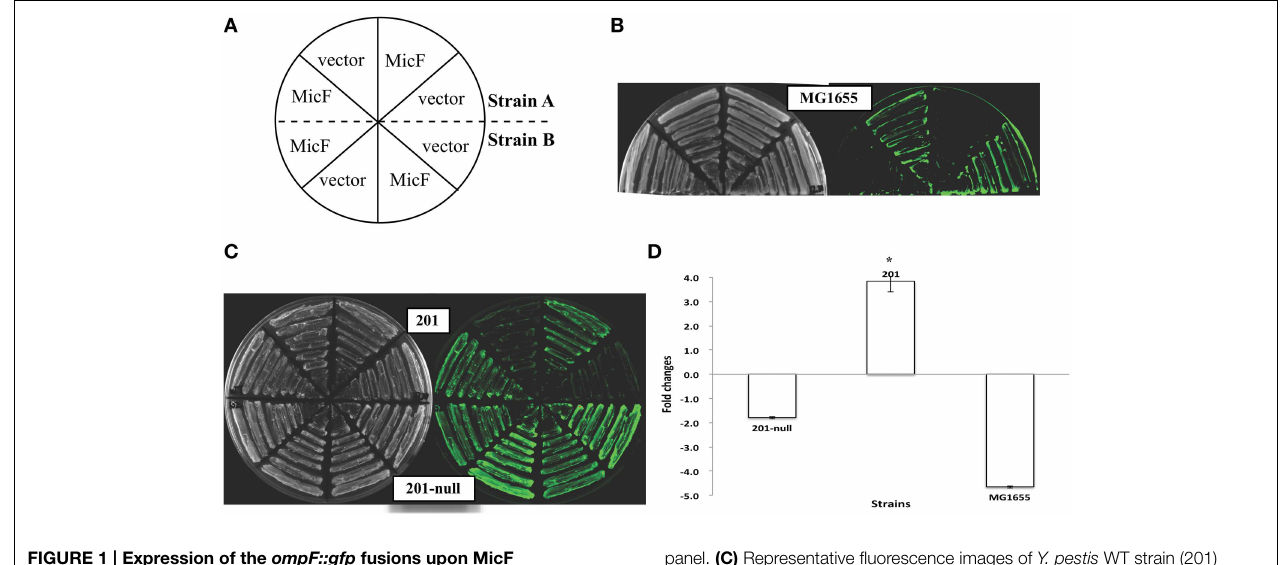
panel. (C) Representative fluorescence images of Y. pestis WT strain (201) and its plasmid-cured derivative strain (201-null). (D) Quantitative measurements of fluorescence produced by the tested strains. Fold changes are provided as the ratio of fluorescence values detected in MicF-overexpressed bacterial strains divided by those detected in strains carrying pBAD blank vectors. Values presented are means ± standard deviations of two independent experiments. The asterisks indicate statistically significant differences compared to the values detected in strain MG1655.